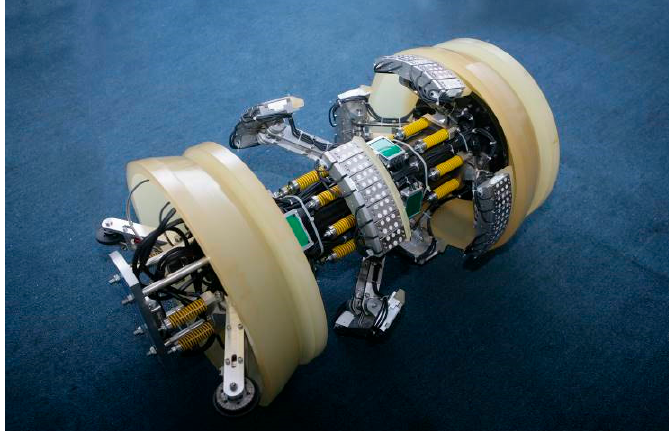
Figure 20. Illegal Hot Tapping in-line inspection tool.